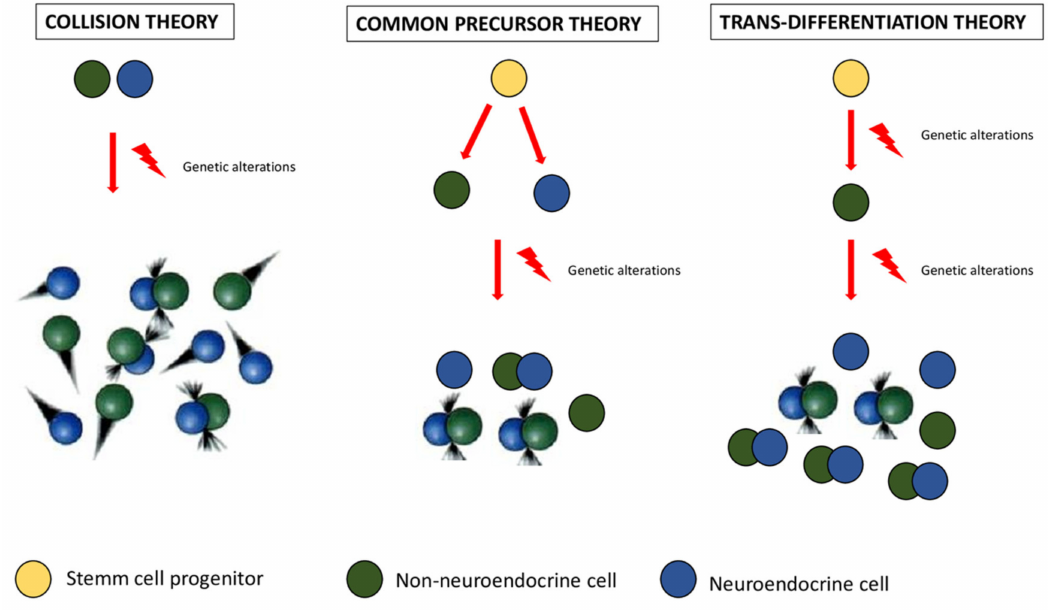
Figure 1. A comprehensive representation of the three main theories about MiNENs’ origin proposed to date. From the left to the right, collision theory, common precursor theory, and trans-differentiation theory are illustrated respectively. As mentioned in the text, the first one suggests that neuroendocrine and non-neuroendocrine components arise independently from distinct precursor cells, the second one postulates a common origin from a pluripotent stem cell progenitor, which differentiates towards both components; finally, the third one assumes that neuroendocrine differentiation is the result of progressive accumulation of genetic alterations in an initially non-neuroendocrine cell